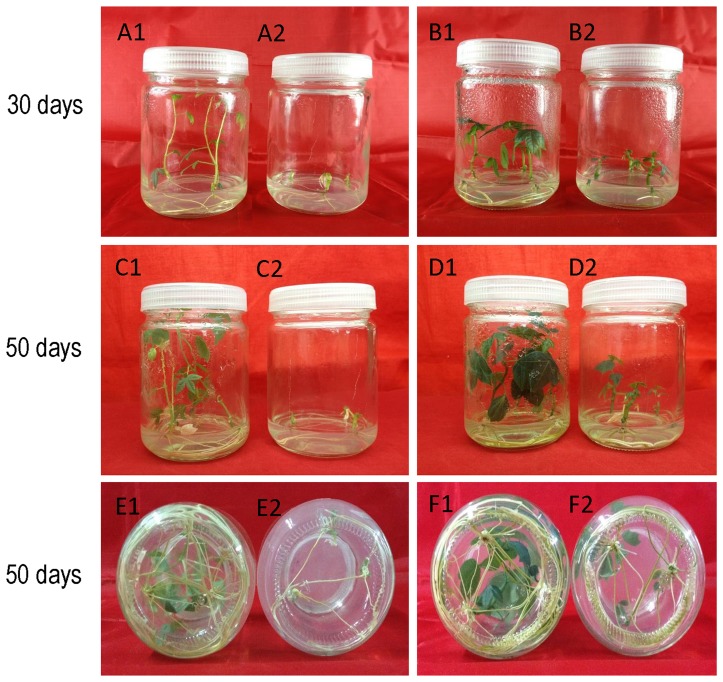
Effects of salt stress on the growth of cassava NZ199 diploid and autotetraploid genotypes.Cassava NZ199 diploid and autotetraploid genotypes were grown at MS medium with 0.03/L NAA used as control, and salt-stressed medium contained MS medium with 0.03 mg/L and 50 mM sodium chloride. A1, C1 and E1 (roots), diploid control; A2, C2 and E2 (roots), salt-stressed diploid plantlets; B1, D1 and F1 (roots), autotetraploid control; B2, D2 and F2 (roots), salt-stressed autotetraploid plantlets.